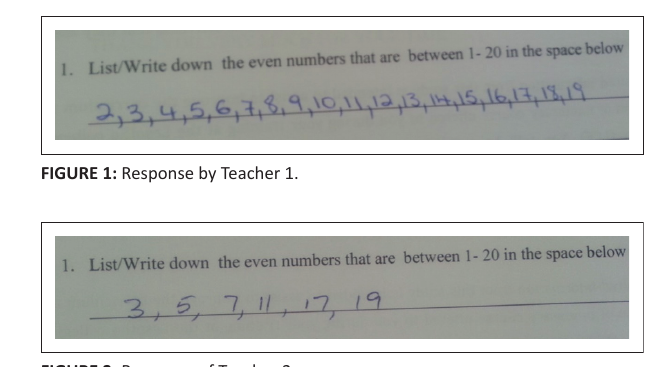
FIGURE 2: Response of Teacher